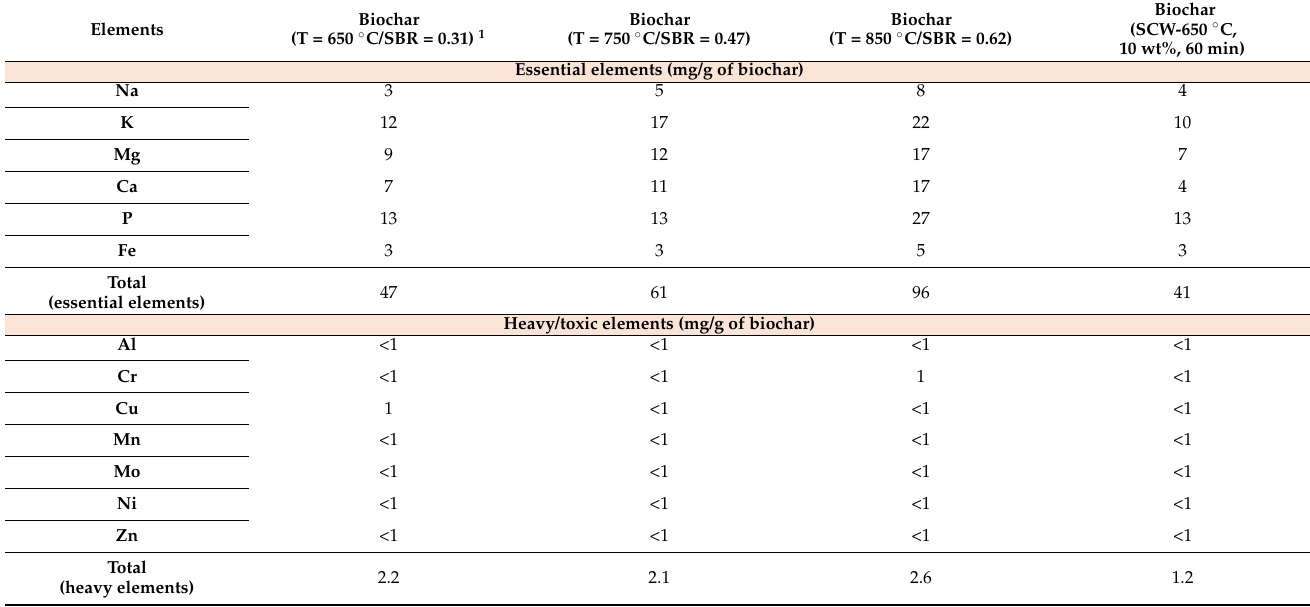
Table 2. ICP-MS results for biochar samples produced from steam and SCW gasification of canola hull fuel